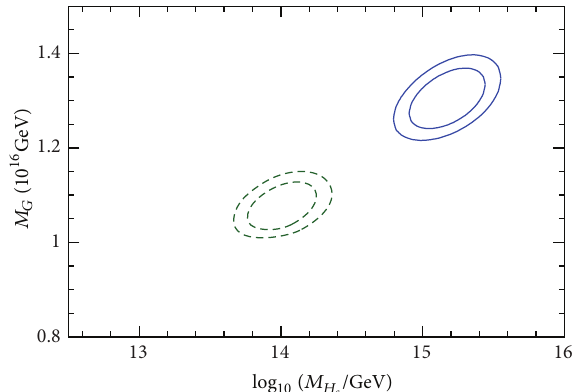
Figure 7: Running of the gauge couplings from the electroweak to the Planck scale from [51]. The discontinuity for 𝜇 = 𝜇 is clearly visible. In panel (b) an enlargement of (a) for the region around 𝜇 = 𝜇 𝜇